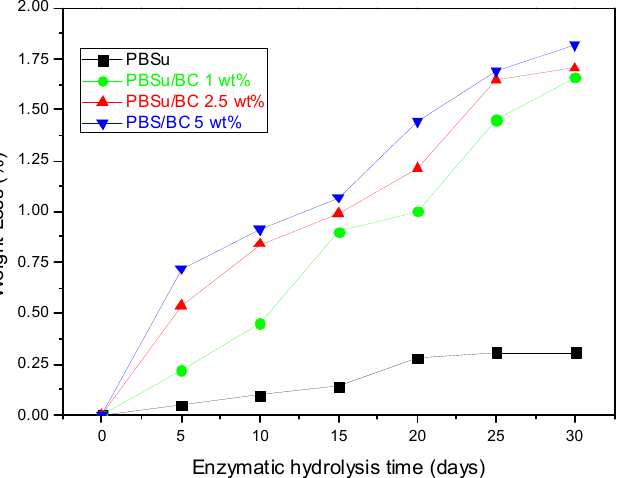
Figure 16. Weight loss vs time plot during enzymatic hydrolysis of neat PBSu and PBSu/BC biocom- posites.